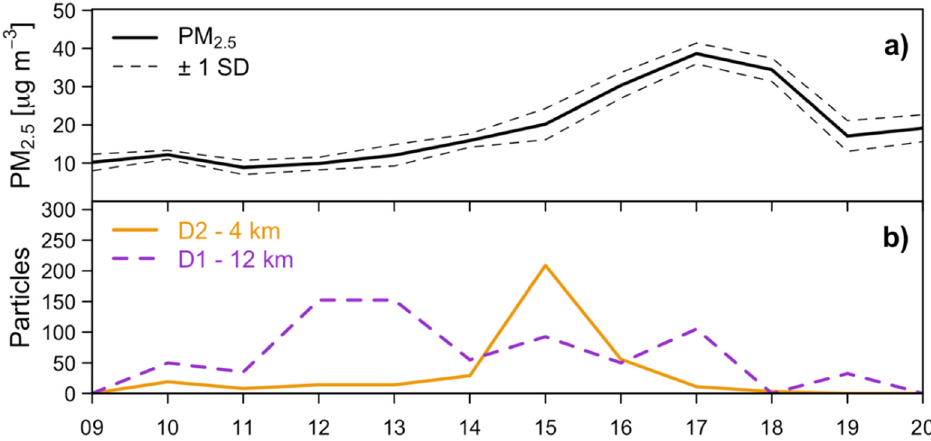
Figure 8. Time series (April 2020) of ( a ) network-averaged daily PM 2.5 ; ( b ) daily number of particles reaching AMVA with elevations lower than 3500 masl.